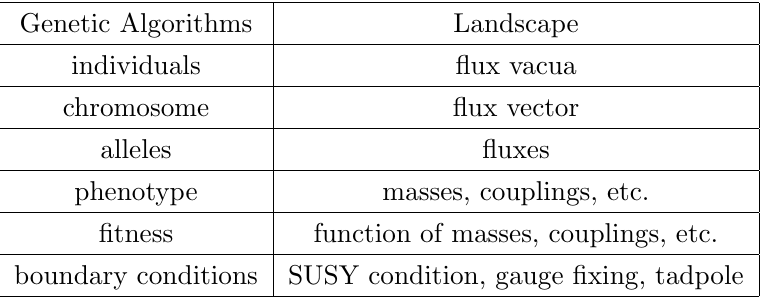
Table 1 . Dictionary relating terms used in the context of GAs and the (cid:13)ux